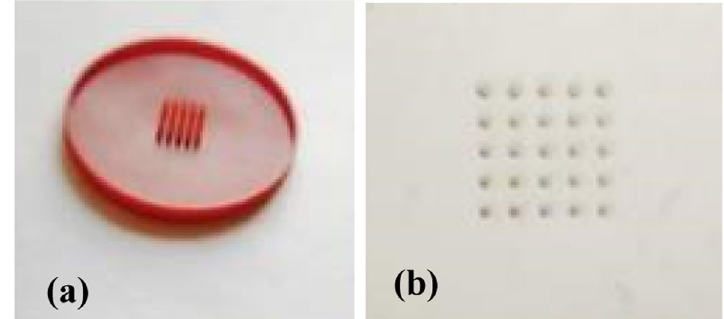
Fig. 2 MN mold. a Positive template fabricated by the 3D printer. b Obtained negative silicone